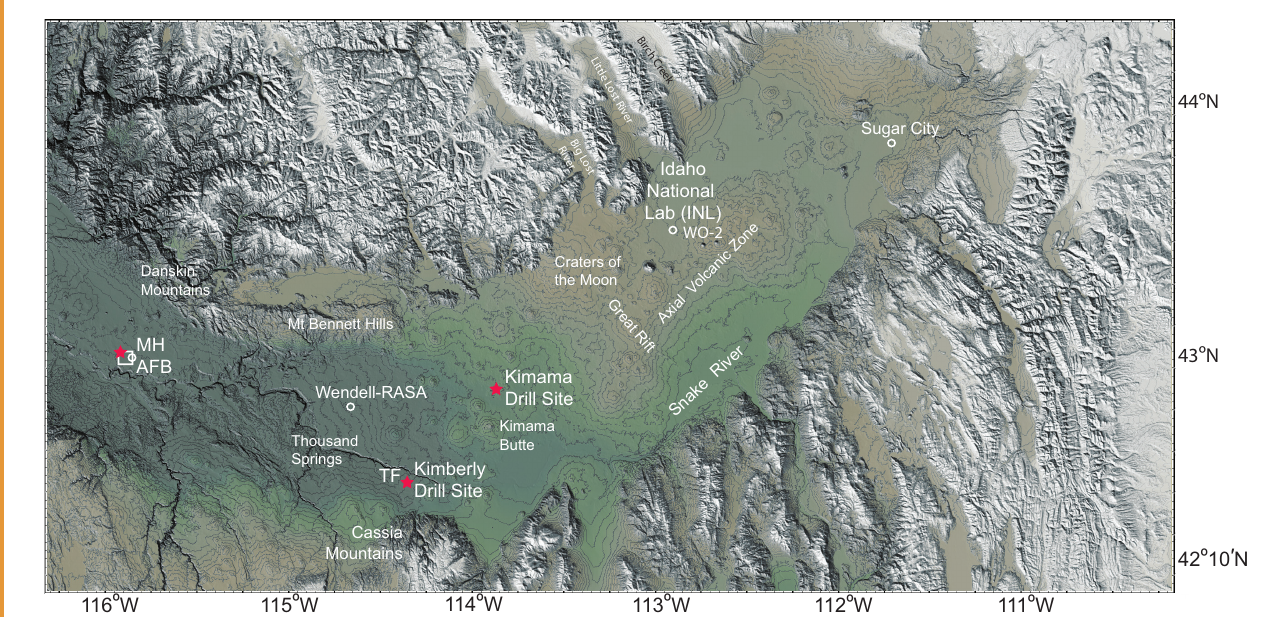
116ºW Figure 1. Shaded relief-topographic map of Snake River Plain derived from NASA 10-m DEM data and contoured at 30-m intervals. Red stars=new drill sites of this project; open circles=legacy drill sites discussed in text. TF=city of Twin Falls, MH AFB=Mountain Home Air Force Base.